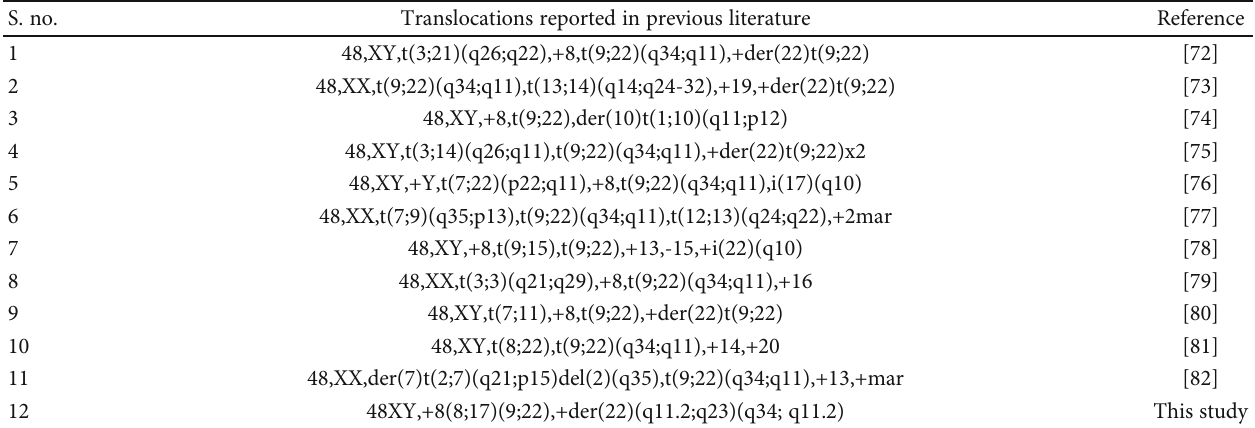
Table 8: Previous reported four-way translocations with two additional